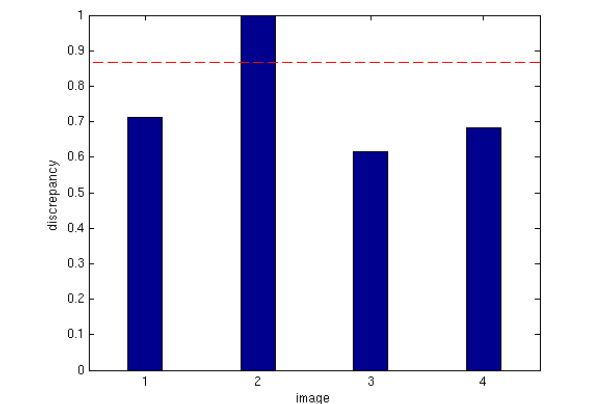
Figure 5. Discrepancy measures for the four images and the adaptive threshold as a dashed red line.